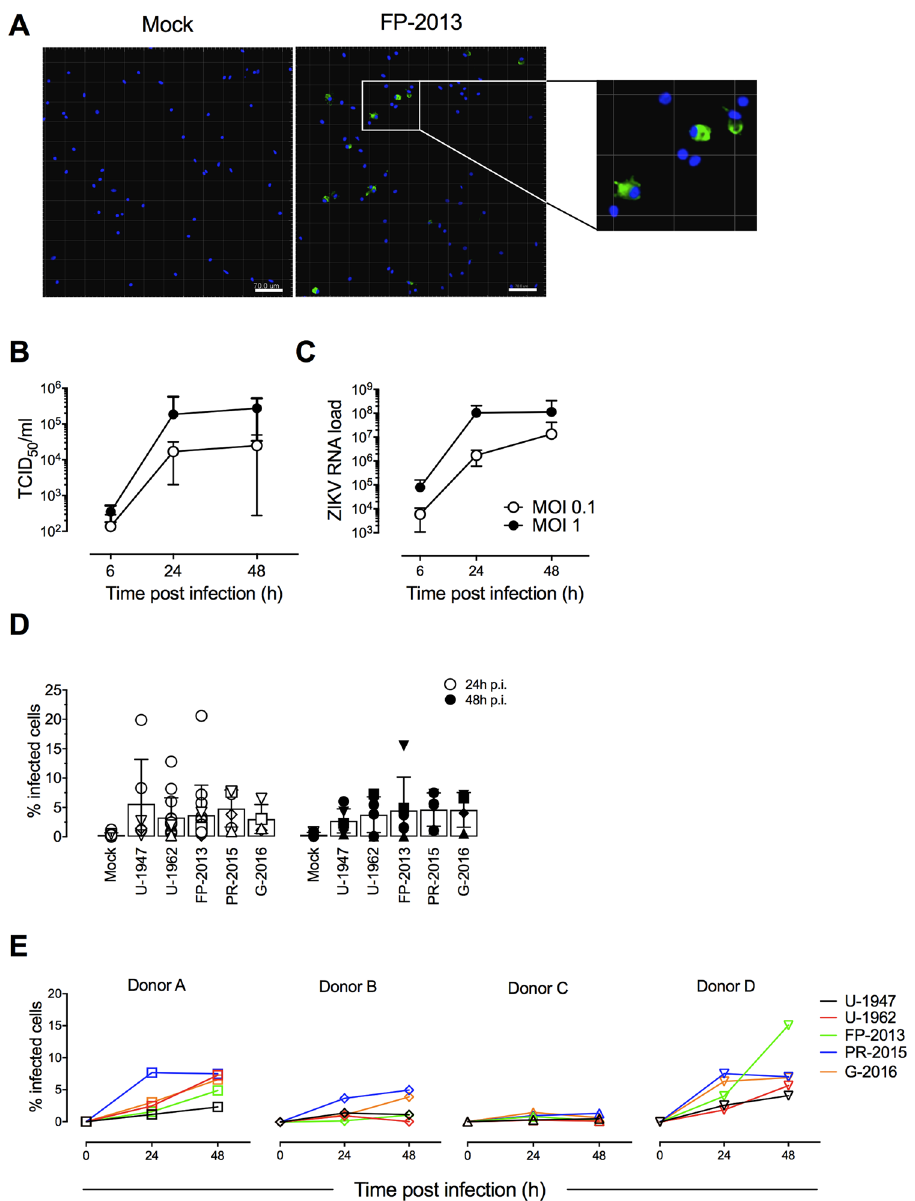
Figure 2. Susceptibility of MoDCs towards African and Asian ZIKV strains infection. ( A ) Confocal microscopy analysis 24 h p.i. with Mock and Asian (FP-2013) lineage ZIKV at a MOI of 1 TCID 50 /cell. Blue: DAPI, Green: ZIKV, bar 70 µ m. The micrographs shown are representative of ZIKV-infected DCs generated from 3 independent blood donors. ( B ) Measurement by TCID 50 assay of infectious ZIKV release in supernatants of MoDC cultures 6, 24, and 48 h p.i. with FP-2013 at a MOI of 0.1 and 1 TCID 50 /cell. ( C ) Measurement of intracellular viral RNA copies by quantitative RT-PCR in MoDC cultures 6, 24, and 48 h p.i. with FP-2013 at a MOI of 0.1 and 1 TCID 50 /cell. Data are presented as mean + / − SD of MoDCs generated from 6 independent blood donors. ( D ) Frequency of ZIKV-infected MoDCs per donor 24, and 48 h p.i. with five ZIKV strains a MOI of 0.1 TCID 50 /cell. Data are presented as mean + / − SD of MoDCs generated from 4–15 independent blood donors. Individual donors are represented with a symbol: square (Donor A), diamond (Donor B), triangle (Donor C), inverted triangle (Donor D). ( E ) Frequency of ZIKV-infected MoDCs for 4 selected donors 24, and 48 h p.i. with five ZIKV strains a MOI of 0.1 TCID 50